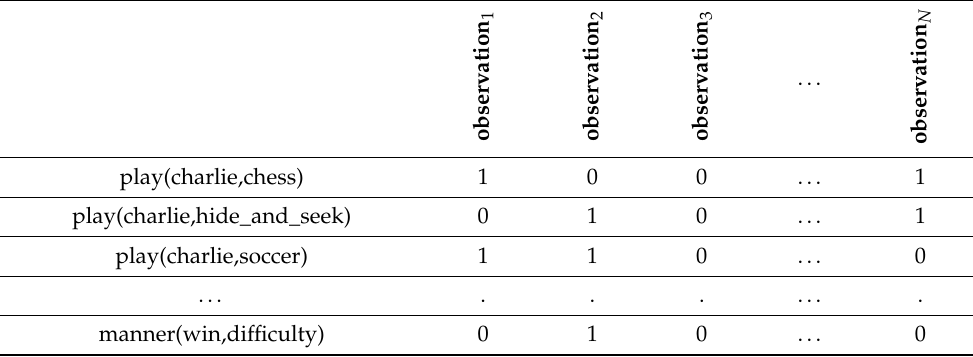
Table 2. Situation Space matrix. Each row constitutes the situation vector of the corresponding basic event. Each column is one observation sampled from the